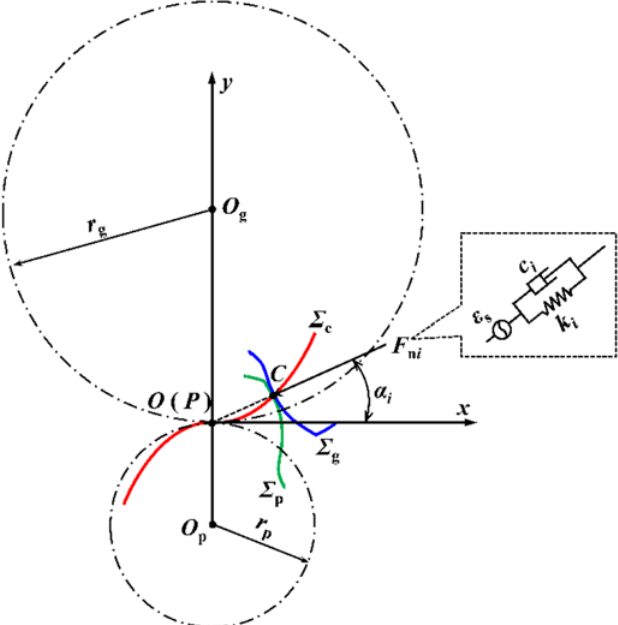
Fig. 3. Effect of curved path of contact on direction of normal tooth